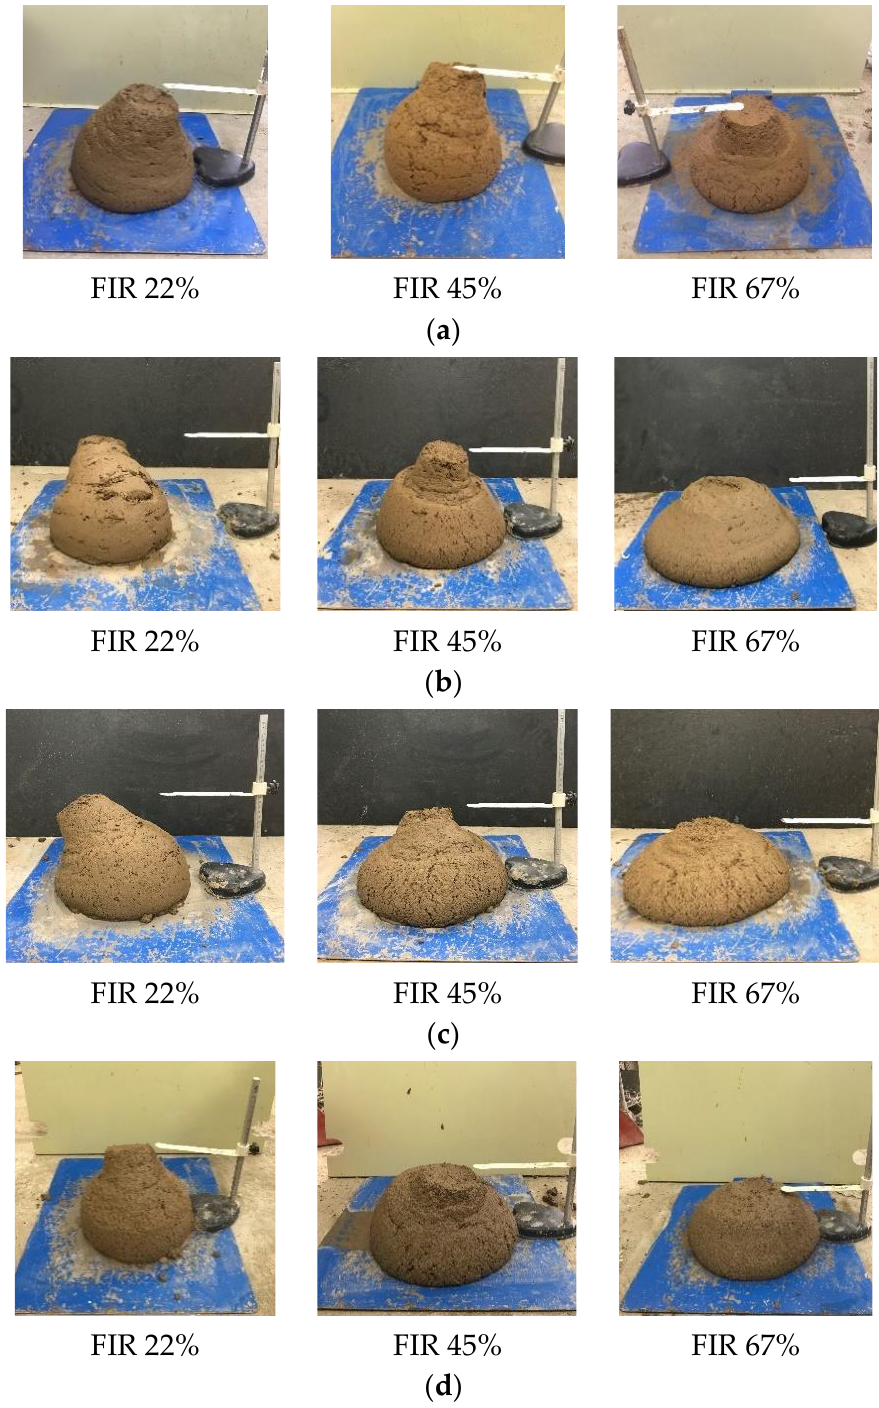
Figure 4. Slump test results with variation in the water content and FIR [10]: ( a ) Soil 1 (water content = 30%), ( b ) Soil 2 (water content = 22.5%), ( c ) Soil 3 (water content = 18%), ( d ) Soil 4 (water content = 15%).